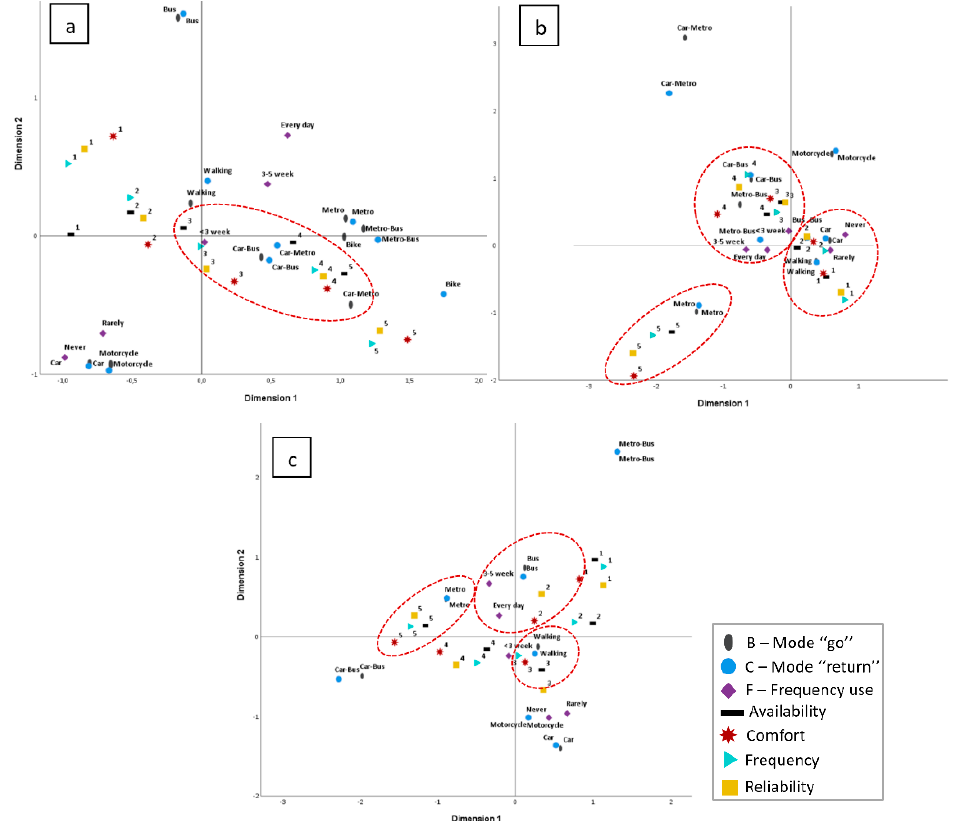
Figure 10. MCA analysis of elements of service quality and travel habits for ( a ) science and technology campus; ( b ) humanities; ( c ) economics (social science).